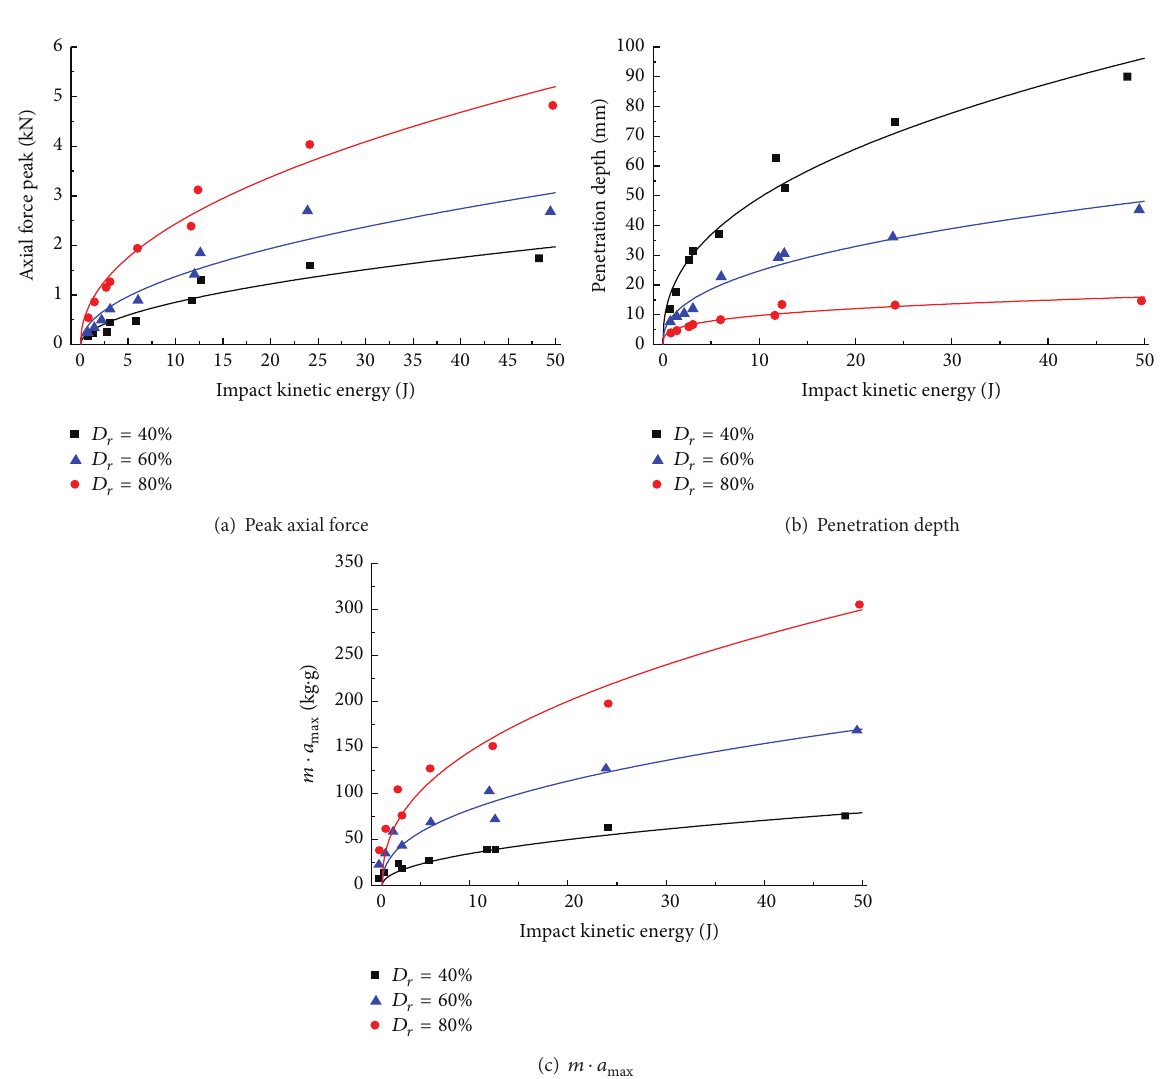
Figure 22: Relationship of peak features with impact kinetic